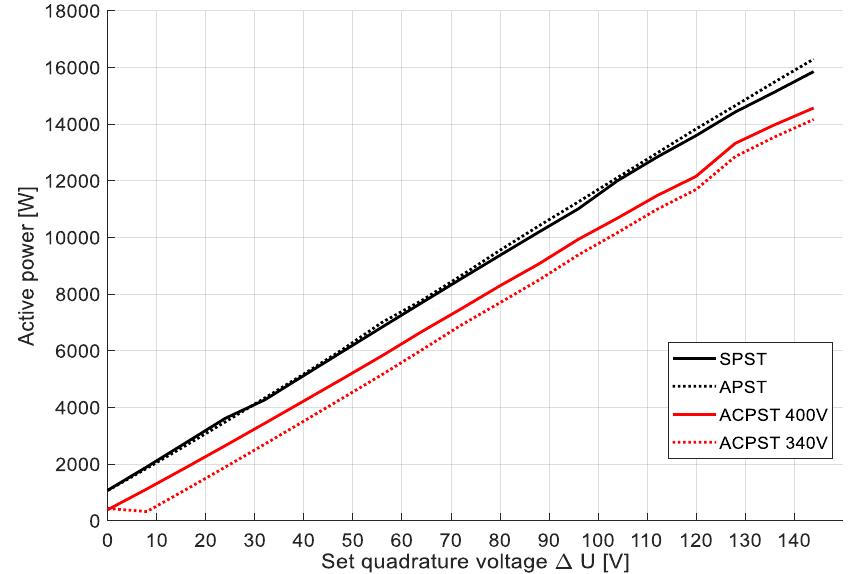
Figure 13. Active power transfer for different PSTs as a function of the set quadrature voltage.